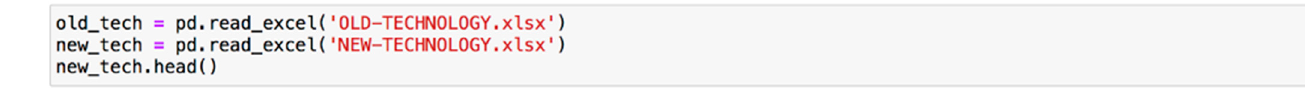
Figure 5. Read data into Pandas Data Frame .